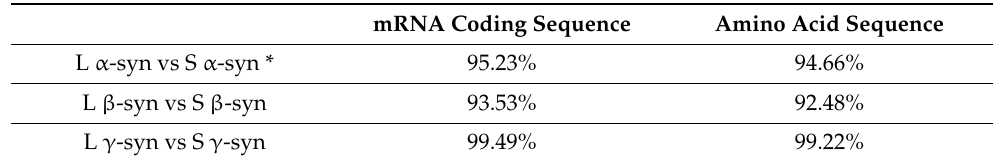
Table 1. mRNA coding sequences and amino acid sequence comparison between L and S syns. * indicates partial sequence.